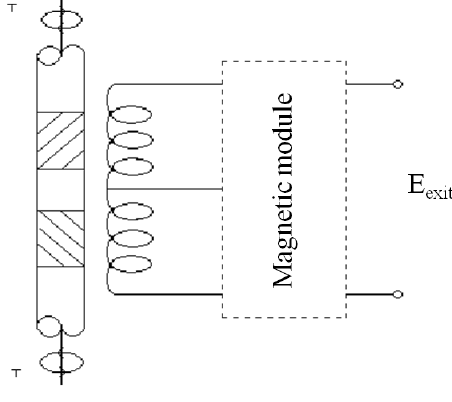
Figure 3. Torque